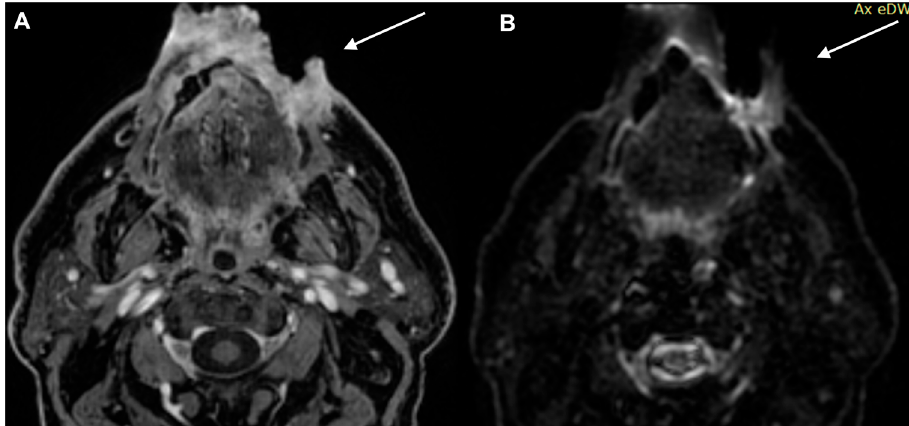
Figure 5. MRI examination of the previous patient. The lesion shows high signal in DWI and inten-sity reinforcement in the contrast-enhanced study image. ( A ) Enhanced MRI imaging and ( B ) DWI.